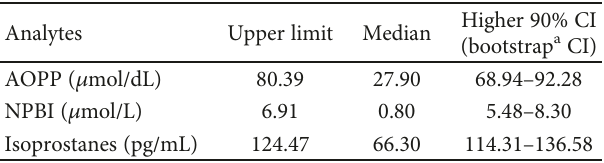
Table 3: Reference interval — right side nonparametric method (CLSI C28-A3) for OS markers in cord